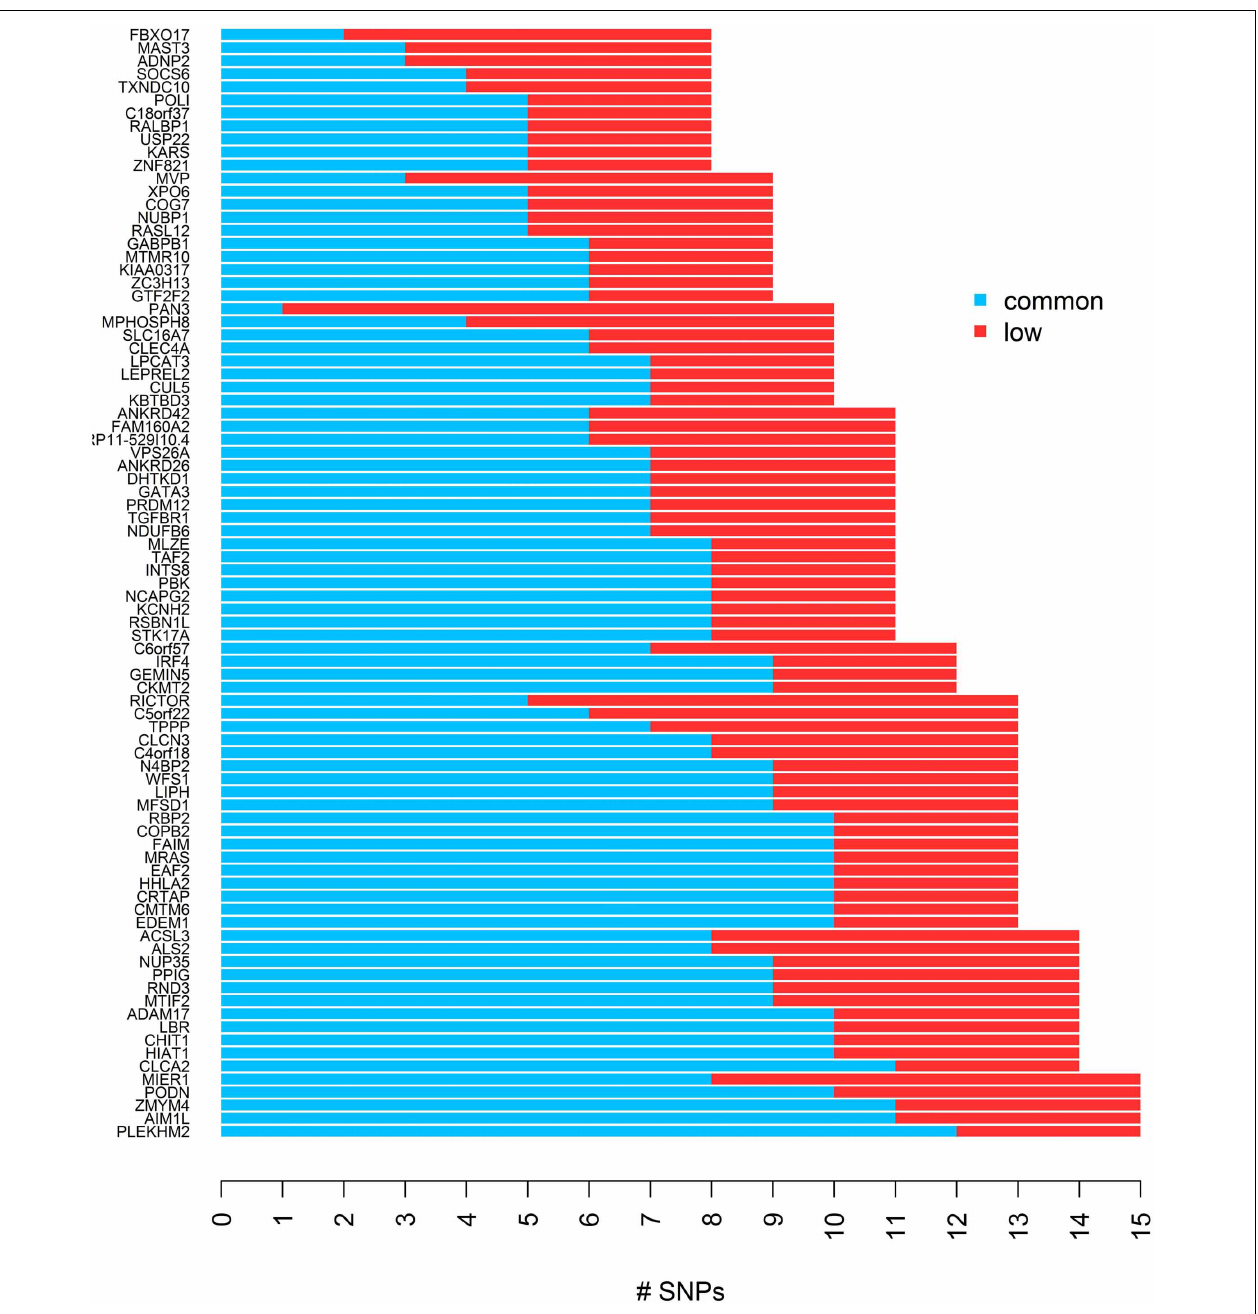
FIGURE 1 | The distribution of common and low frequency SNPs for each of 85 genes used for the simulation